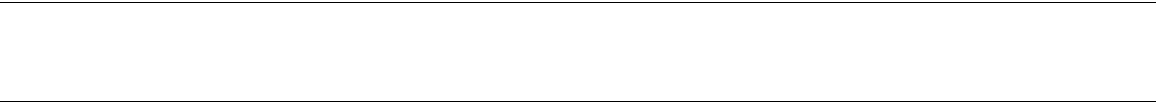
Frontiers in Plant Science | Plant